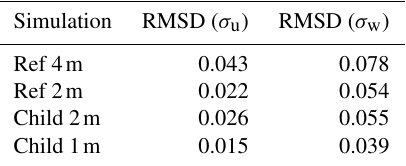
Table 1. Root-mean-square deviation (RMSD) of the simulated u and w standard deviations evaluated against the corresponding wind tunnel measurements at the positions shown in Figs. 14 and 15. The RMSD is evaluated at all respective heights of the observations and is averaged over all heights and profile